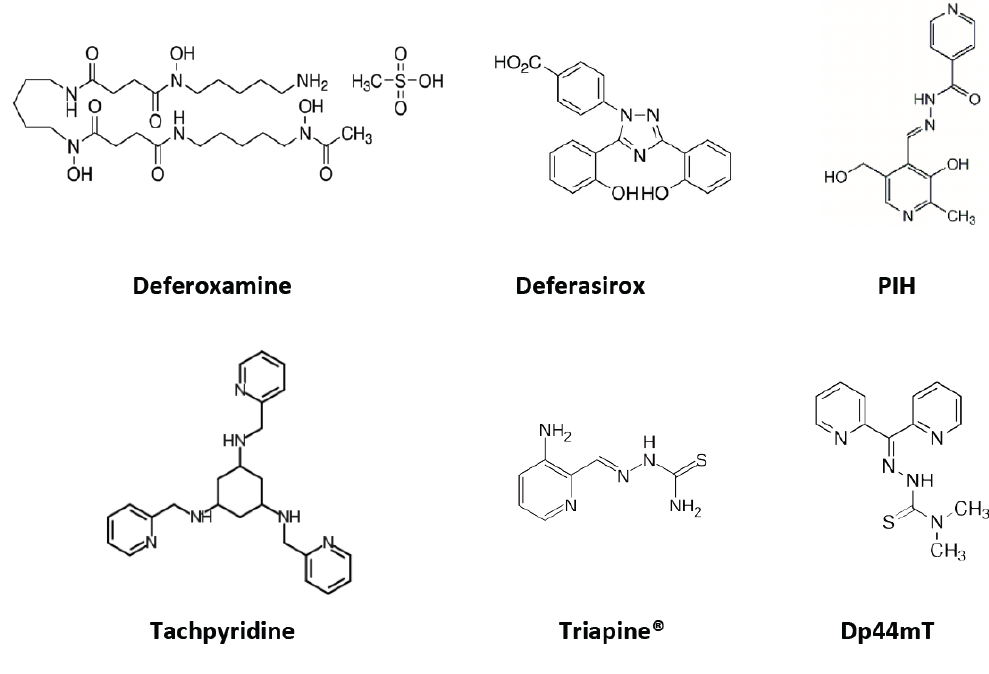
Figure 4. The chemical structure of several key iron chelators. Abbreviations: PIH––pyridoxal isonicotinoyl hydrazone; Dp44mT––di-2-pyridylketone-4,4,-dimethyl-